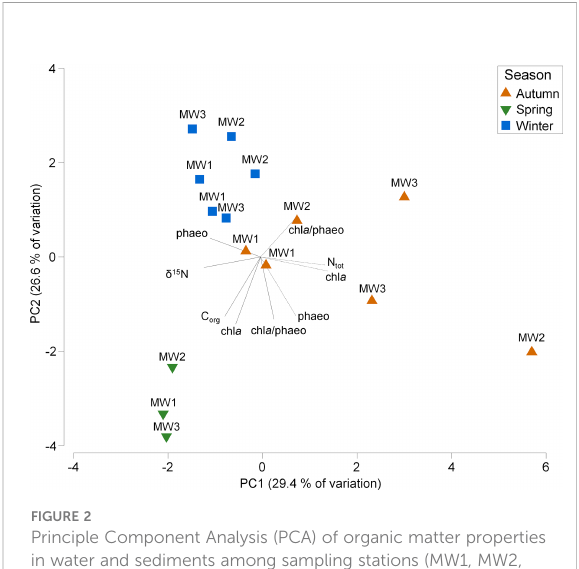
FIGURE 2 Principle Component Analysis (PCA) of organic matter properties in water and sediments among sampling stations (MW1, MW2, MW3) and seasons. Solid lines indicate important water variables, whereas dotted lines indicate important sediment